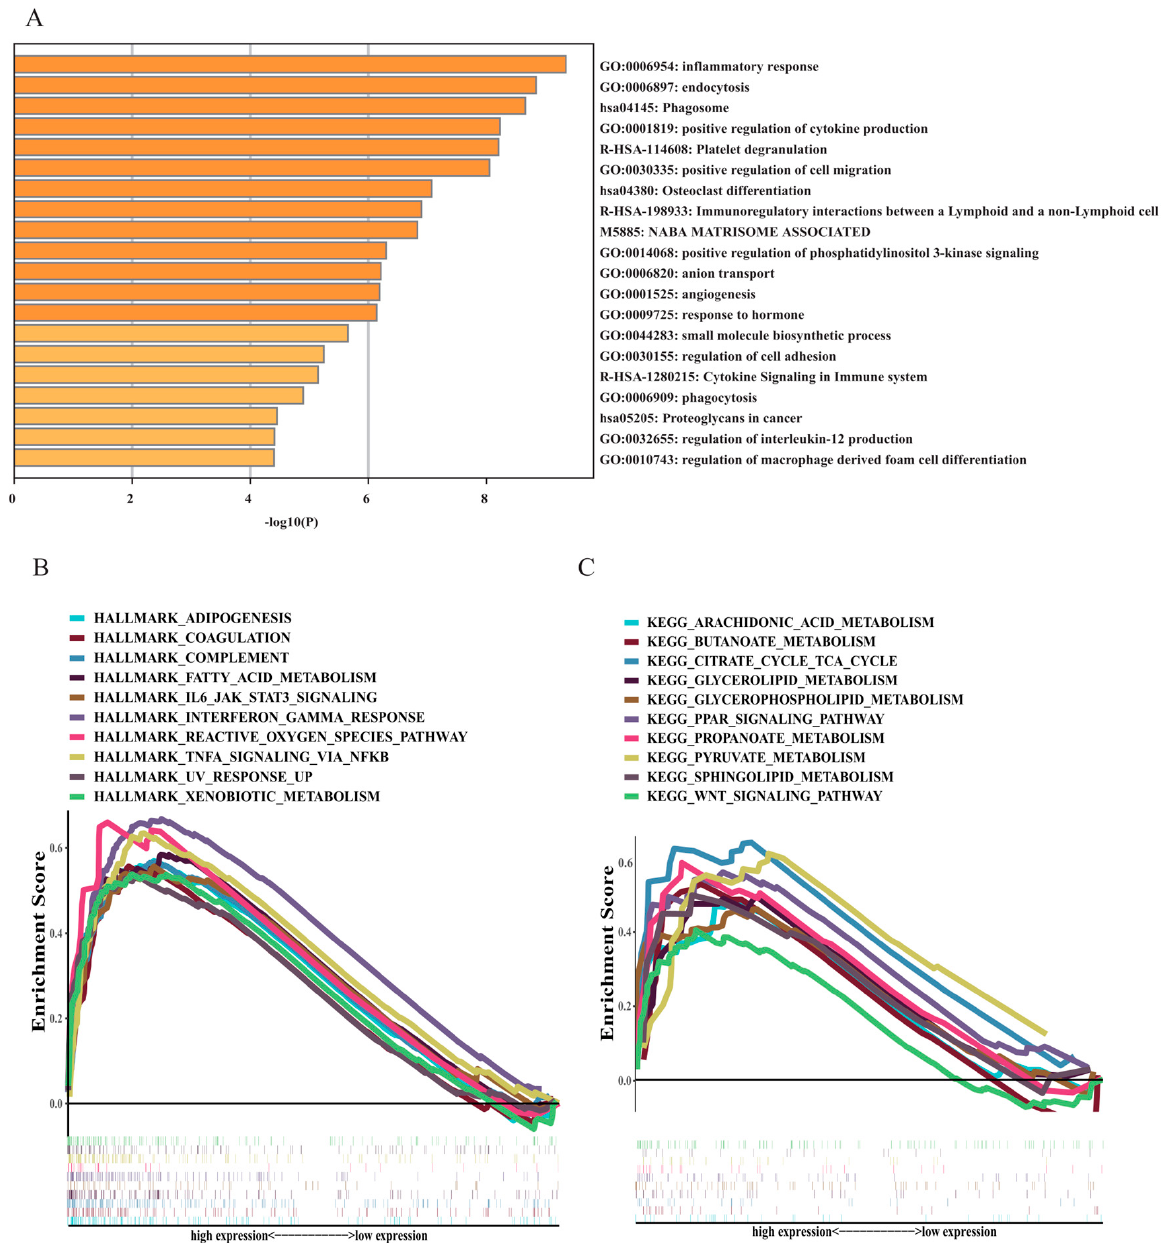
Figure 7. Function and pathway enrichment analysis. ( A ) Function and pathway enrichment analysis by Metascape. The image shows the histogram of the top 20 enriched pathways. ( B , C ) GSEA results.